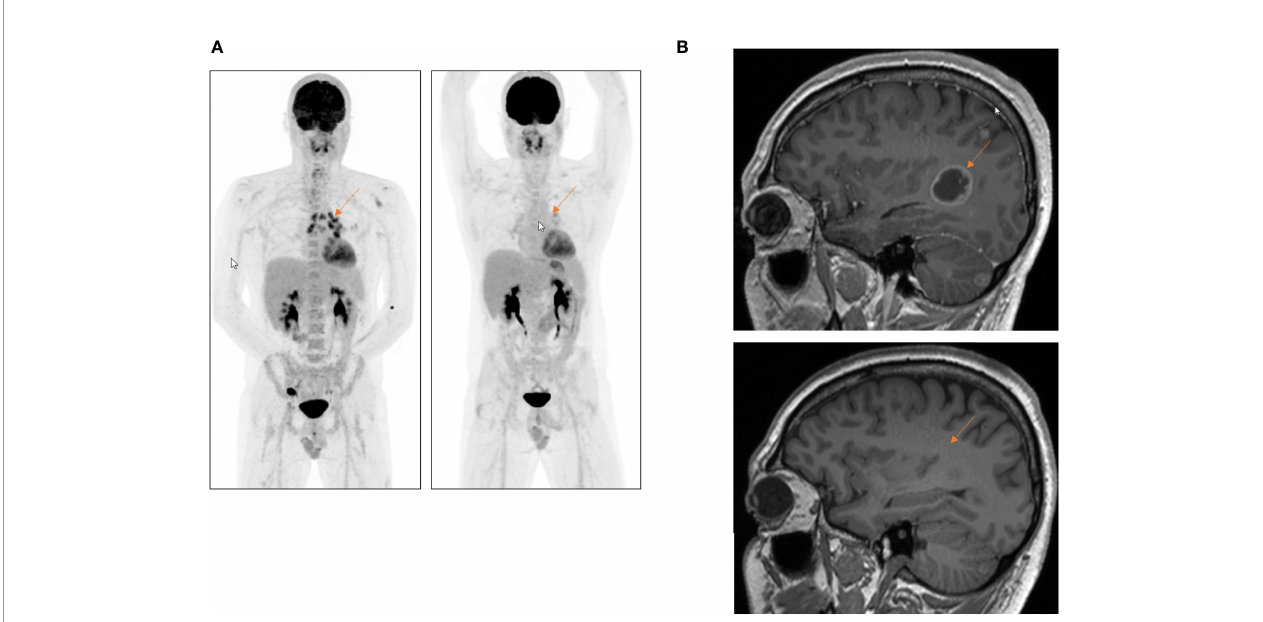
FIGURE 3 | First-line treatment with alectinib in a 37-year-old patient with a metastatic ALK -rearranged LCNEC. (A) FDG-PET scan, whole-body overview, before (left) and 12 weeks after (right) initiation of fi rst-line treatment with alectinib. (B) Complete response of the multiple brain metastases 10 weeks after the start of alectinib. Whole-brain radiation could be avoided. Red arrow shows excellent tumor response under treatment with alectinib.